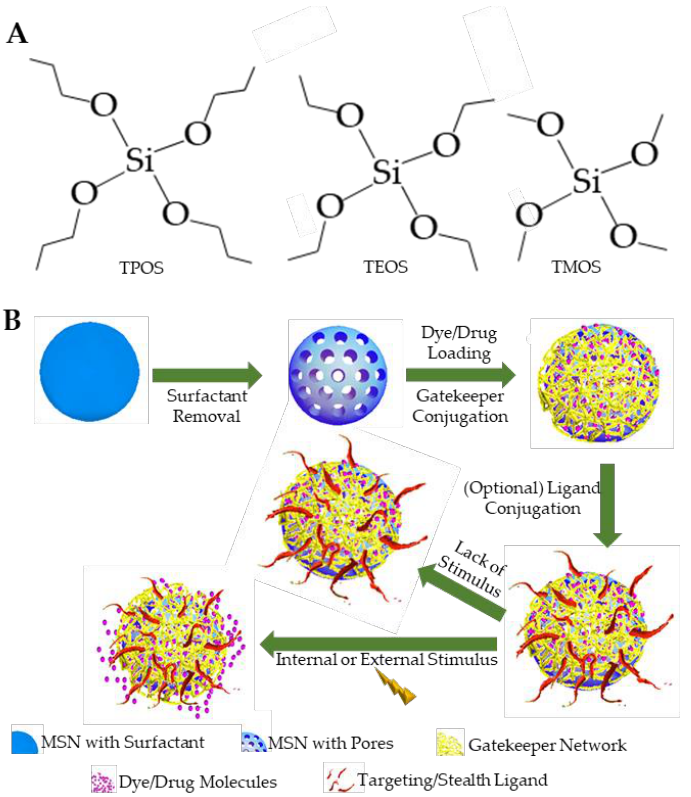
Figure 2. MSN precursors and theragnostic action. ( A ) The common orthosilicate precursors used in MSN synthesis reactions. ( B ) MSN synthesis, loading, and controlled release. Note that the surface of the MSN is coated with a biocompatible gatekeeper. The biocompatible gatekeeper has a dual role in that it allows retention or release of dye/drug molecules and facilitates biocompatibility of the nanoparticle to reduce toxicity. A stimulus can result in swelling or destruction of a stimuli-responsive gatekeeper. A dye/drug can release based upon stimuli-responsive changes in the gatekeeper, regardless of the presence/absence of an active targeting molecule by diffusion.